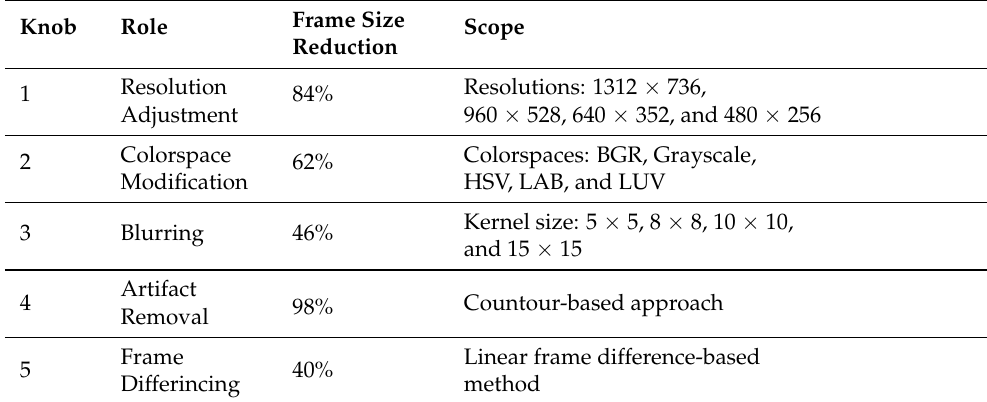
Table 3. The knob configuration and